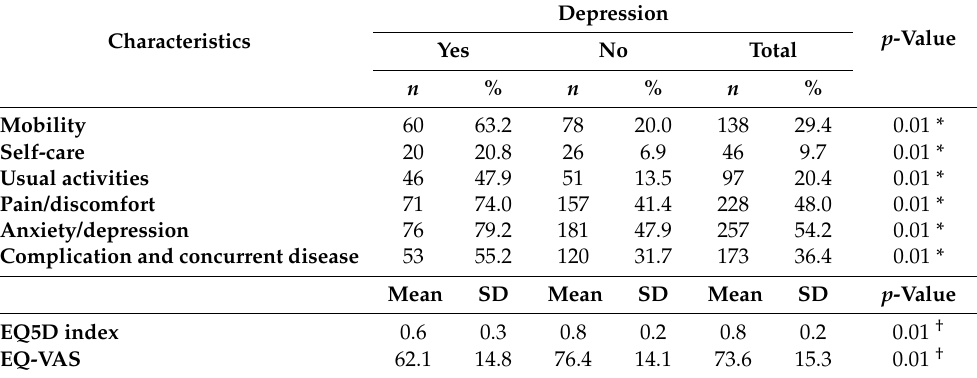
Table 4. Health-related quality of life among patients receiving ART ( n =